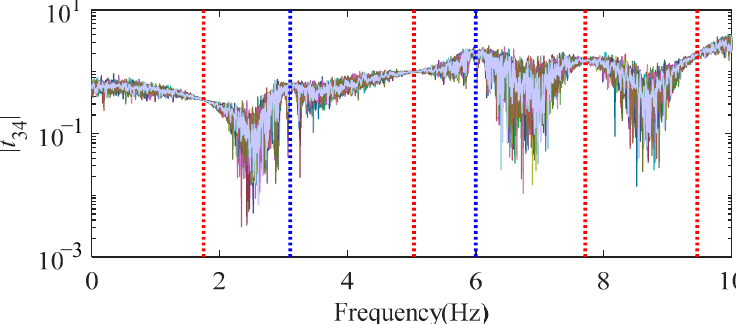
( b ) Figure 4. Acceleration dynamic response of the system. ( a ) DOF 3; ( b ) DOF 4. 3.1.2. Modal Parameter Identification Based on TRF The acceleration dynamic response of 100 s was divided into 20 groups of equal length, the TRF t 34 between DOF 3 and DOF 4 was estimated using the H v method, and the obtained 20 groups of t 34 are shown in Figure 5, which is represented by a curve with